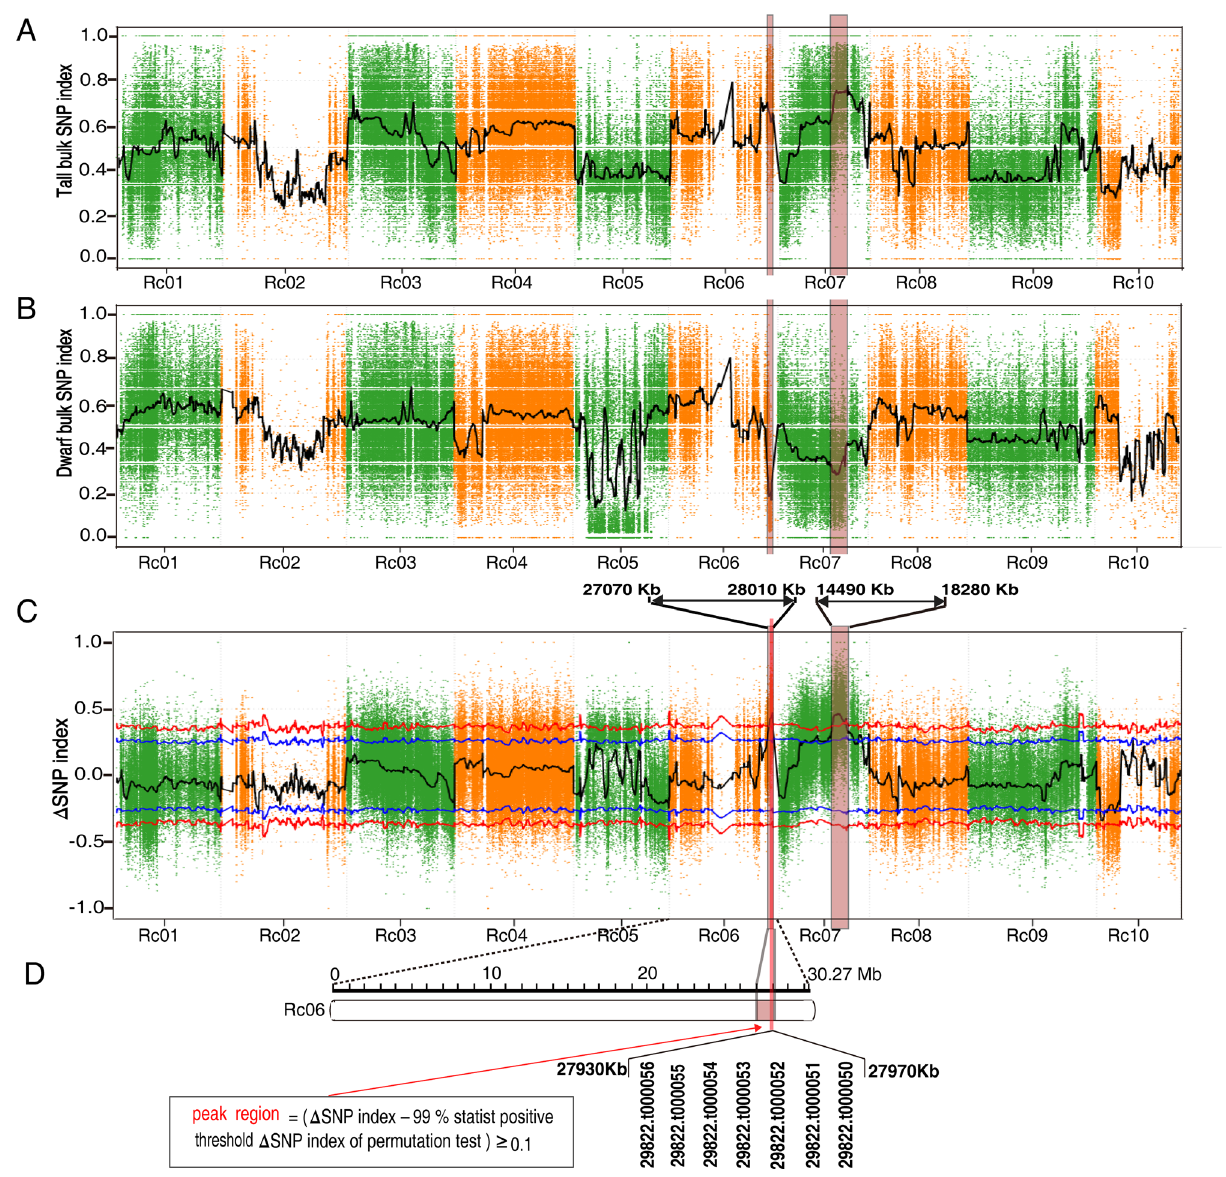
Figure 3. BSA for QTLs contributed to plant height using 1 Mb sliding windows with a step size of 10 Kb. SNP- index of ( A ) tall bulk and ( B ) dwarf bulk. The black curve line represents the average SNP index of each window. ( C ) ΔSNP index. The ΔSNP index of each SNP was computed as the difference between the tall SNP index and the dwarf SNP index. The black curve represents the average of ΔSNP index of each window, blue and red lines represents the 95% and 99% statistical confidence intervals, respectively, based on 1000 permutation tests to each window under the null hypothesis of no QTL. The pink rectangles in ( A ), ( B ) and ( C ) represent the QTLs ( p value < 0.01). The red vertical line in ( C ) is the QTL1 peak region. Rc01-Rc10 in abscissa are the 10 castor bean chromosomes according to 41 . ( D ) The peak candidate region located under QTL1 covers seven genes. The pink rectangle and red vertical line are the same as in ( C